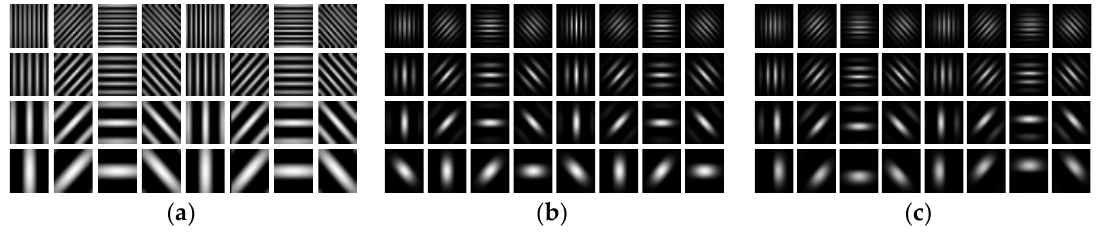
Figure 2. Part of traditional Gabor filters with different parameters: ( a ) σ = 15 , θ = 0°–360° (from left to right), λ = 2,4, 10,20 (from top to bottom), and ψ = 0 ; ( b ) σ = 5 , θ = 0°– 360° (from left to right), λ = 2,4, 10,20 (from top to bottom), and ψ = 0 ; ( c ) σ = 5 , θ = 0°~360° (from left to right), λ = 2, 4,10,20 (from top to bottom), and ψ = 5 .